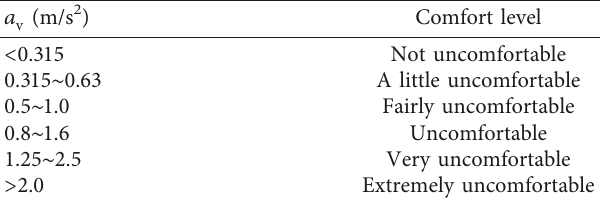
Table 5: Subjective criteria for ride comfort. a (m/s 2 ) Comfort v